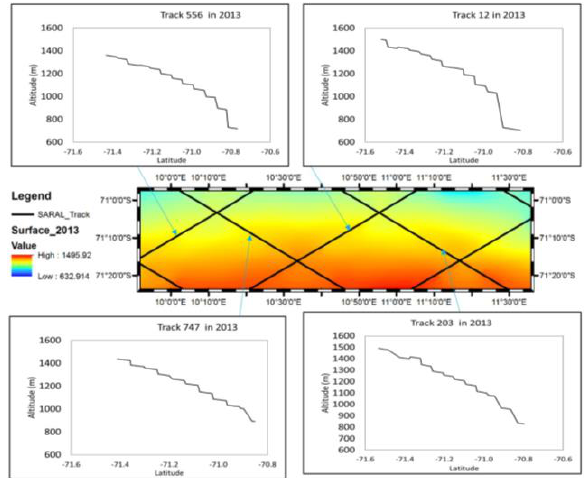
Figure 11. Ice Sheet Elevation profile for